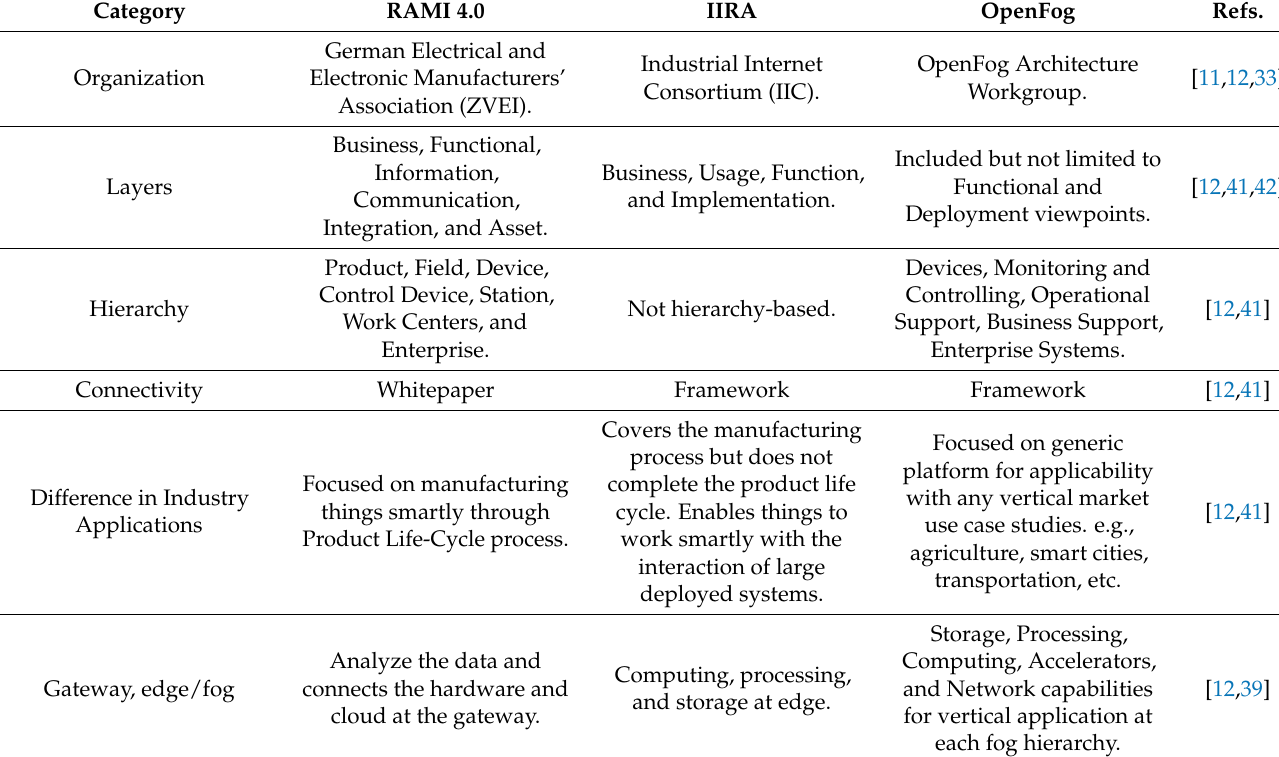
Table 2. Comparison of Industrial IoT reference